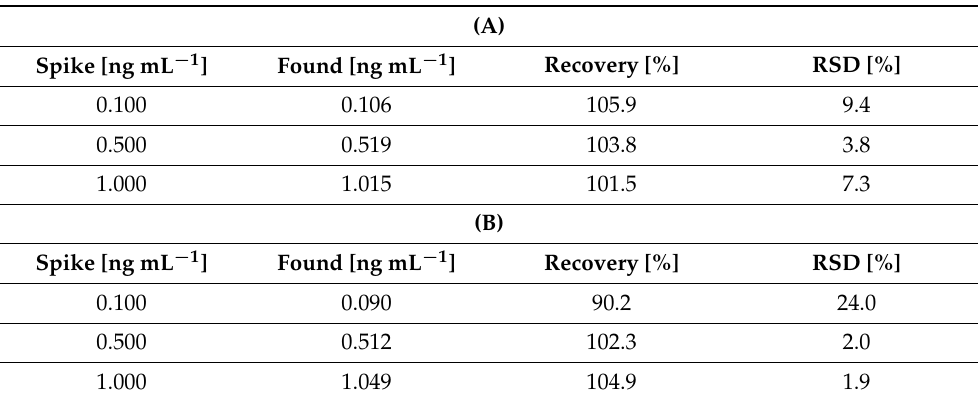
Figure 5. Calibration graphs for cathepsin S with biosensors formed on Ag/Au (open circles) and Au (closed circles) chips. Antibody concentration 20 ng mL −1 and pH = 7.4. Table 1. A. Precision and recoveries of the determination of cathepsin S with the biosensor formed on the Ag/Au chip ( n = 24). B. Precision and recoveries of the determination of cathepsin S with the biosensor formed on the Ag/Au chip ( n =